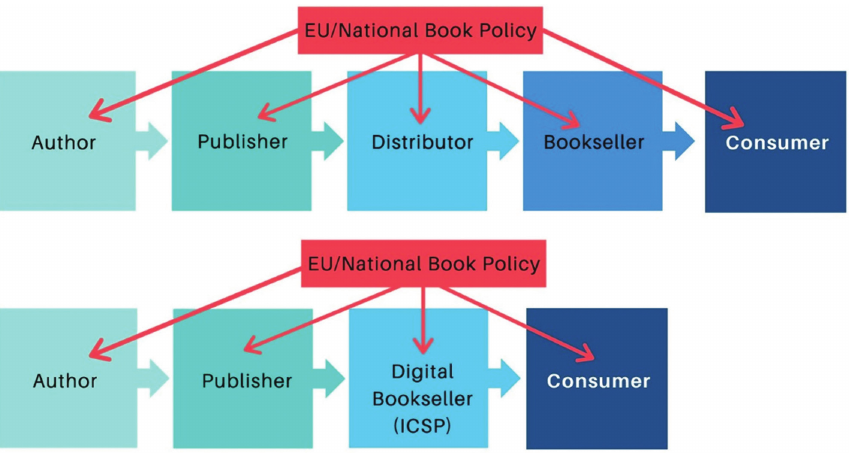
Fig. 1: General book trade